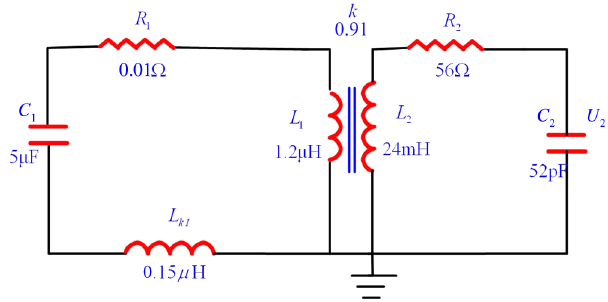
lations for case 2.